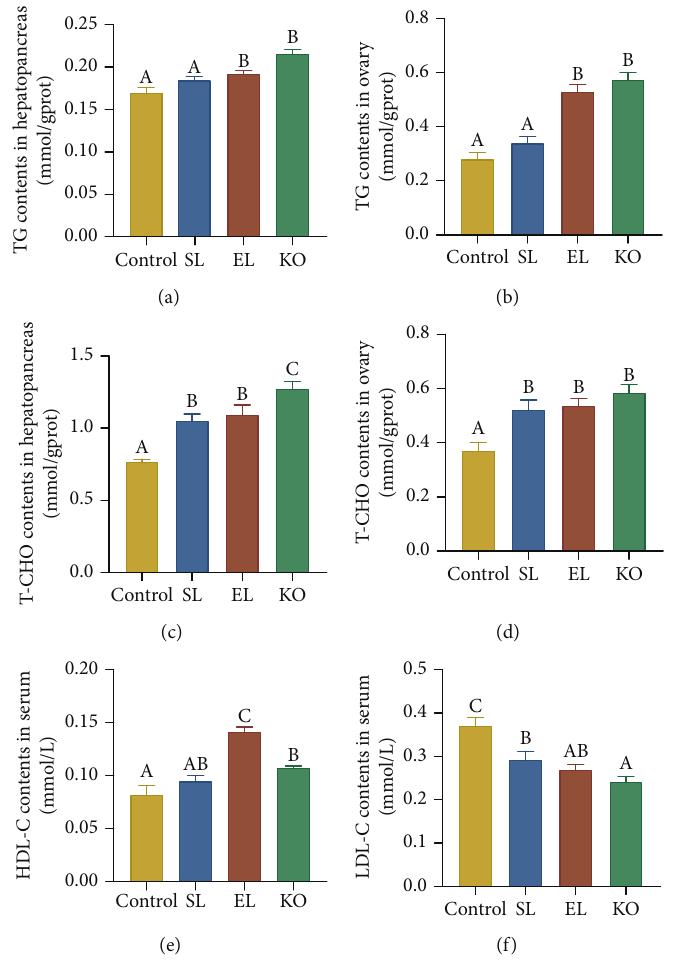
Figure 3: Lipid contents of C. quadricarinatus fed four diets with di ff erent phospholipid sources for 10 weeks. TG contents (a) and T-CHO contents (b) in hepatopancreas tissue. TG contents (c) and T-CHO contents (d) in ovary tissue. HDL-C contents (e) and LDL-C contents (f) in serum. Data are expressed as the mean ± SEM (standard error of the mean) ( n = 4 , replicate tanks). Di ff erent uppercase letters (A, B, and C) indicate signi fi cant di ff erences ( P < 0 : 05 ) ( C > B > A ). TG = triacylglycerol; T-CHO = total cholesterol; HDL-C = high-density lipoprotein cholesterol; LDL-C = low-density lipoprotein